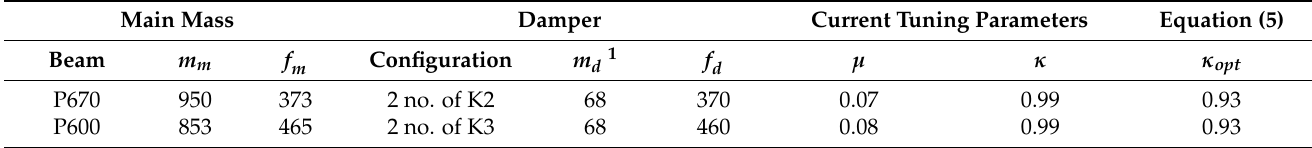
Table 4. Tuning the core-coating